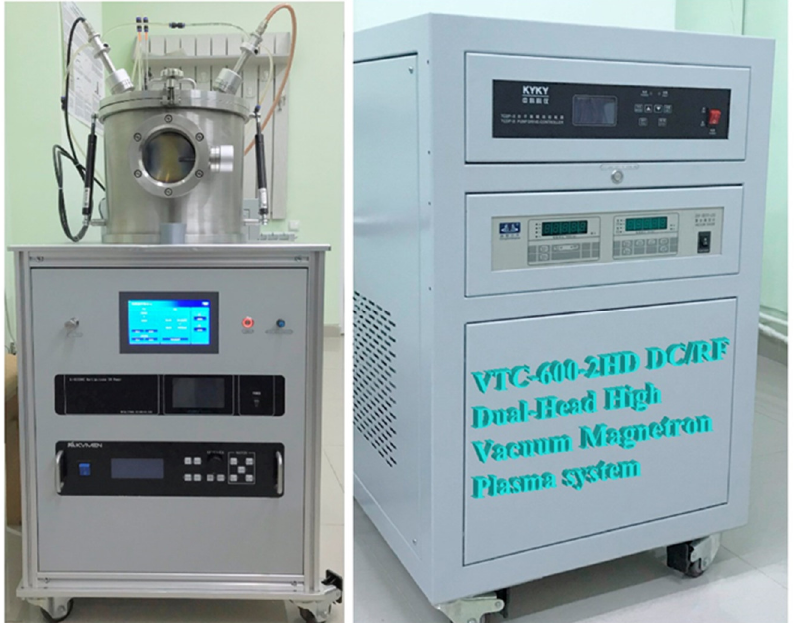
Figure 2. Actual photograph of the VTC-600-2HD DC/RF Dual-Head High Vacuum Magnetron Plasma System.